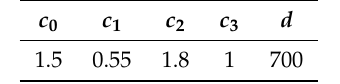
Table 1. Assigned hysteresis loss parameters.